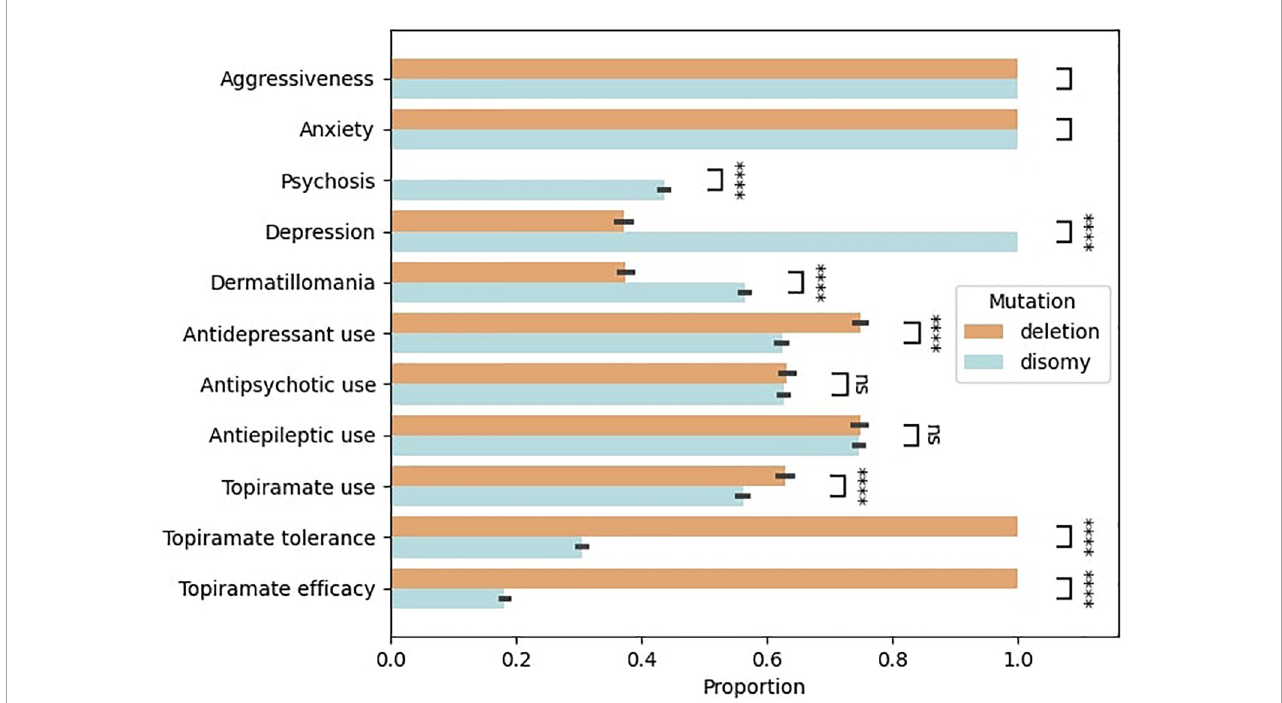
FIGURE1 Clinical profile of patients with Prader–Willi syndrome depending on the genetic mutation (deletion versus disomy). Bootstrap simulation based on the 24 patients of the cohort. A T -test was used to compare the bootstrapped distributions. ∗∗∗∗ Simulated p -value <